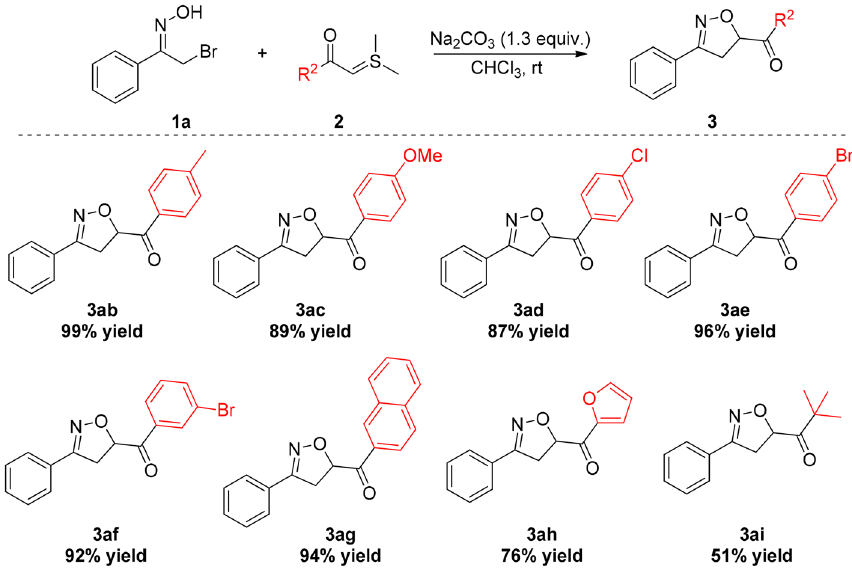
Figure 3. [4 + 1] annulation of α-bromooxime 1a with various sulfur ylides 2.